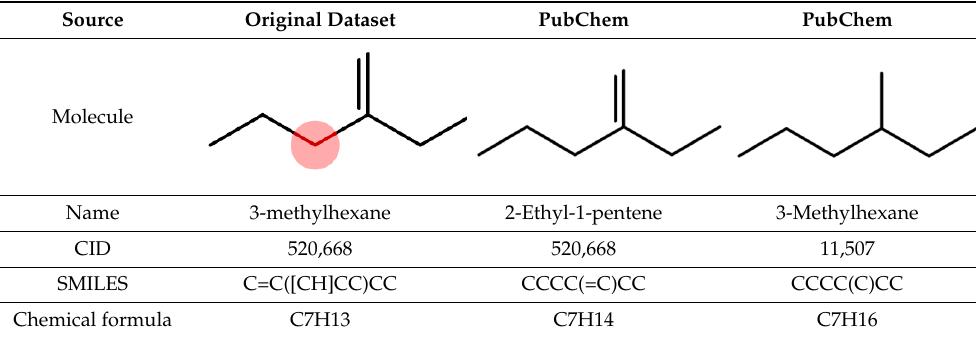
Table 5. Example of a molecule identified using the ‘Unusual valence’ checker. The molecule from the original dataset has a carbon atom with a missing hydrogen. Its name and PubChem CID correspond to two different molecules.